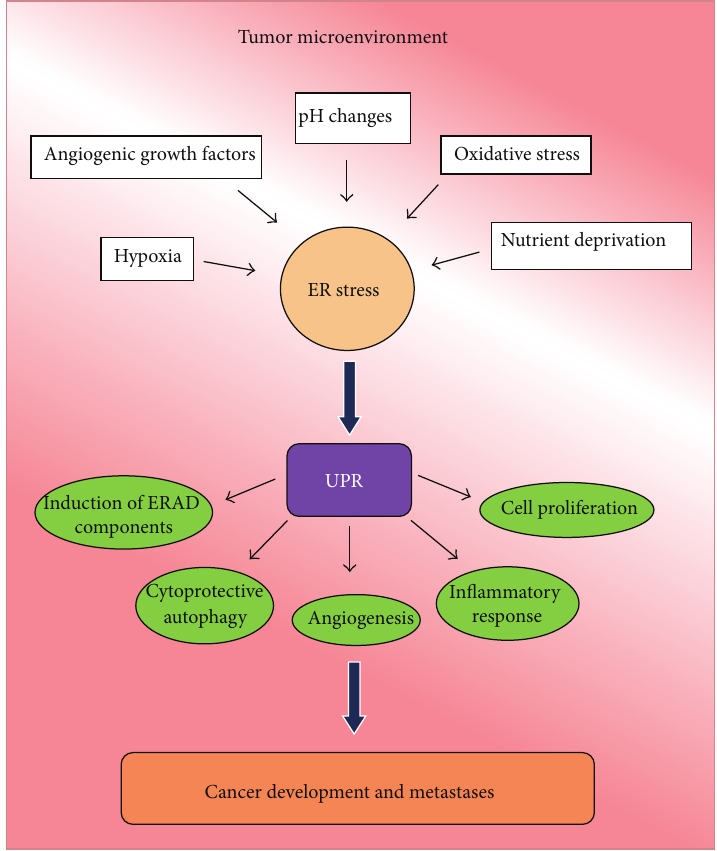
Figure 2: Tumor microenvironment factors activate ER stress and UPR responses leading to cancer development and